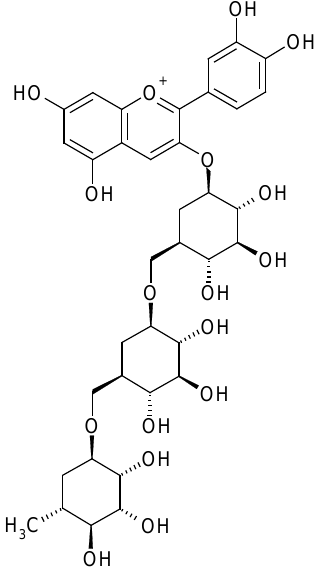
Figure 3. Cyanidin 3- O -glucosyl-rutinoside [29].